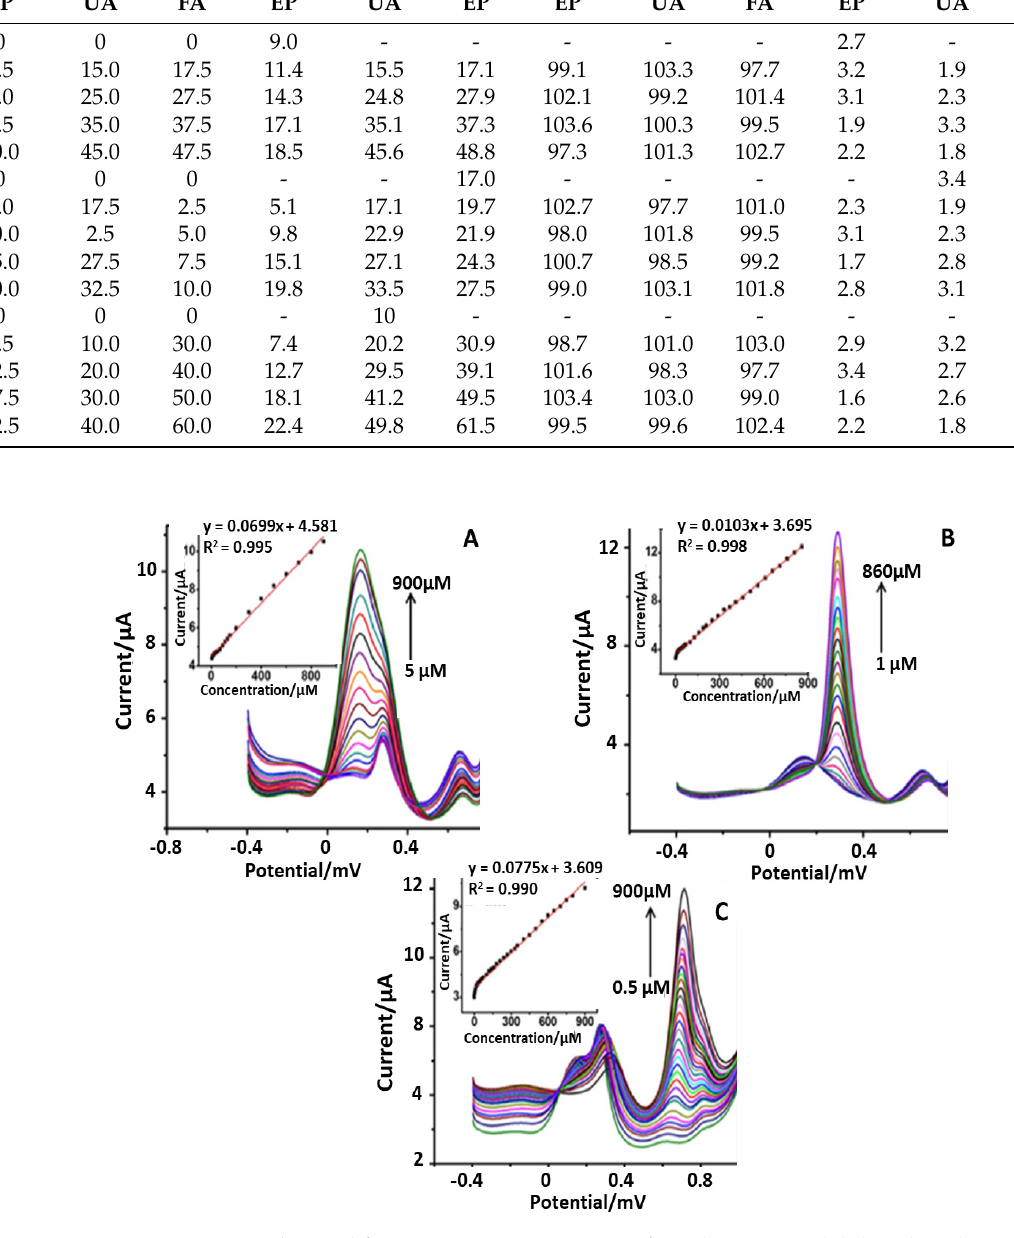
Figure 3. ( A ): SWVs obtained for various concentrations of UA (5 to 500 μ M) and FA (1 to 800 μ M) at Mn SnO 2 /GCE in the presence of 200 μ M AA in 0.1 M PBS (pH 6.0). ( B , C ): plots of the oxidation peak currents as a function of various concentrations of UA and FA, respectively [51].